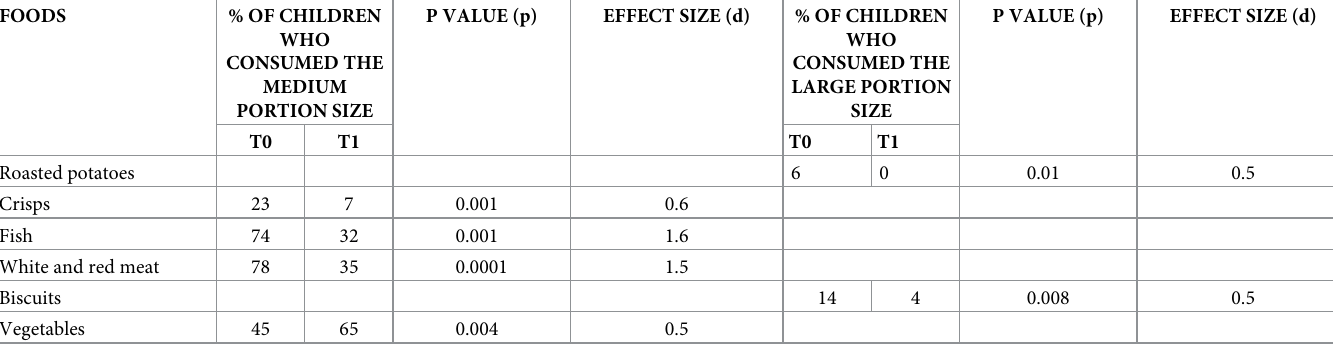
The statistical analysis was performed using the Chi-squared test. Numerical data were converted into percentages as reported in Table 5. P value (p) < 0.05 and effect size (d) > 0.5 indicate values that were statistically